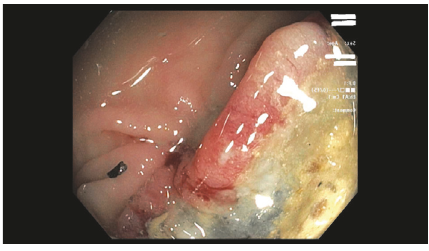
Figure 2: Transverse colon mass.